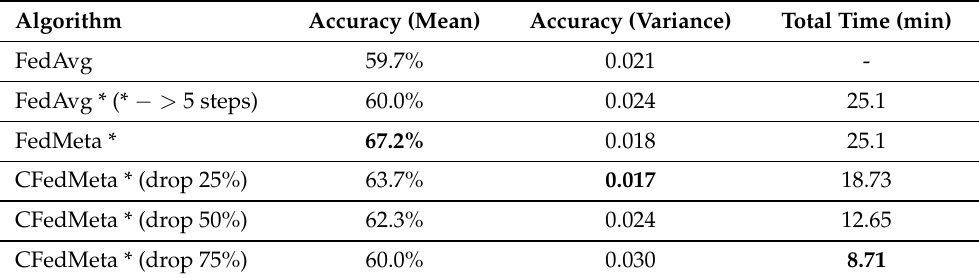
Table 3. Clustering based federated meta-learning (FedMeta) approach. CFedMeta, federated meta-learning with clustering. * indicates 5 rounds of fine-tuning on the global model.